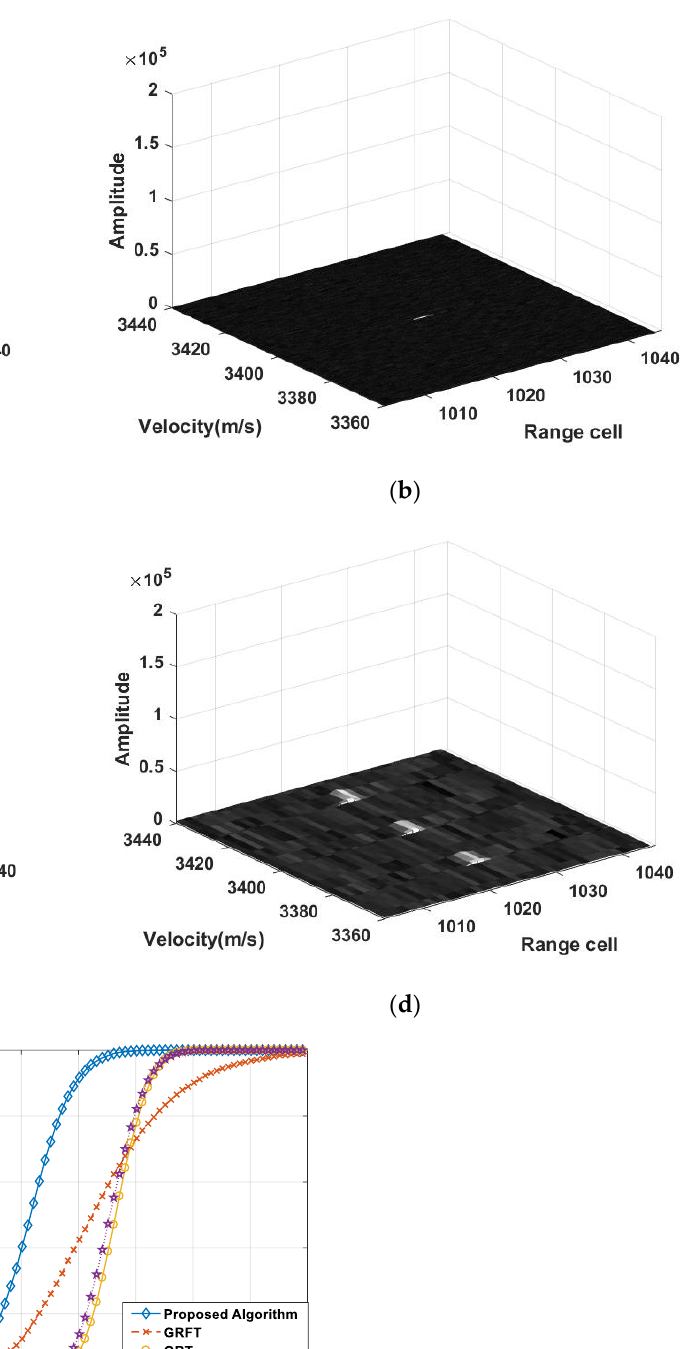
Figure 6. Simulation results in case 1. ( a ) Integration result via GRT; ( b ) Integration result via GRFT; ( c ) Integration result via the proposed method; ( d ) Integration result via MTD-GRT [47]; ( e ) Detec- tion performance for four integration methods [47].